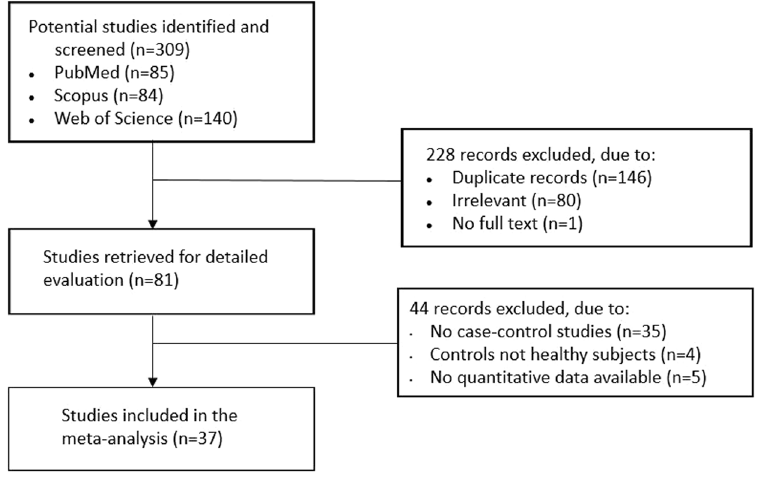
Figure 1. Flowchart of study